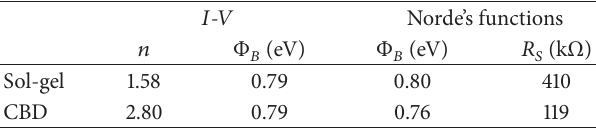
Table 2: Ideality factor, barrier height, and series resistance values of the MIS structures.